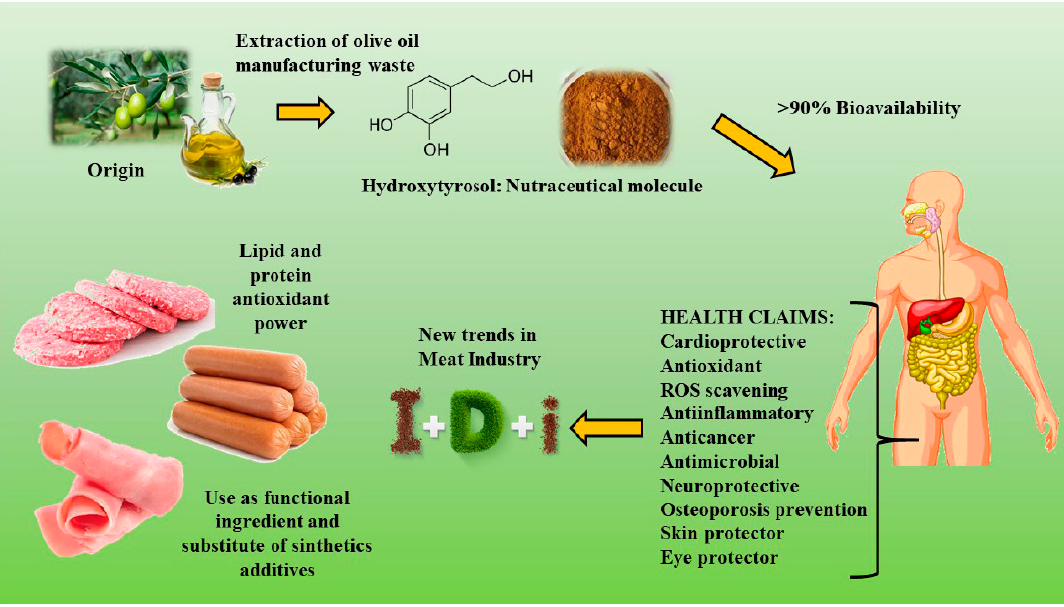
Figure 1. Graphical abstract of the use and health benefits of Hydroxytyrosol to prevent lipid and protein oxidation and substitution of synthetic additives in meat products.